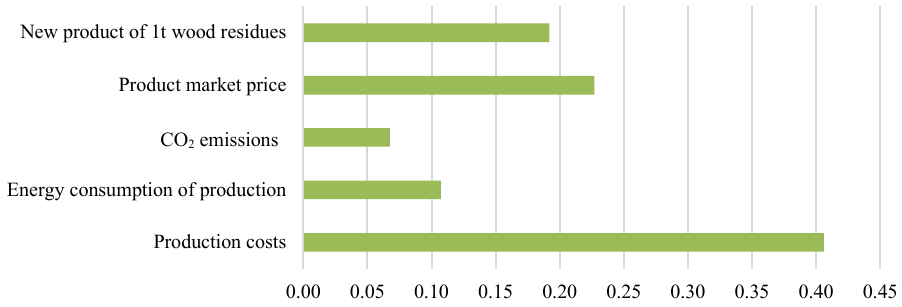
0.00 0.05 Fig. 2. Weighed criteria. Weights of criteria are determined using analytical hierarchy process un input form expert interviews. The sum of all weights is equal to 1.